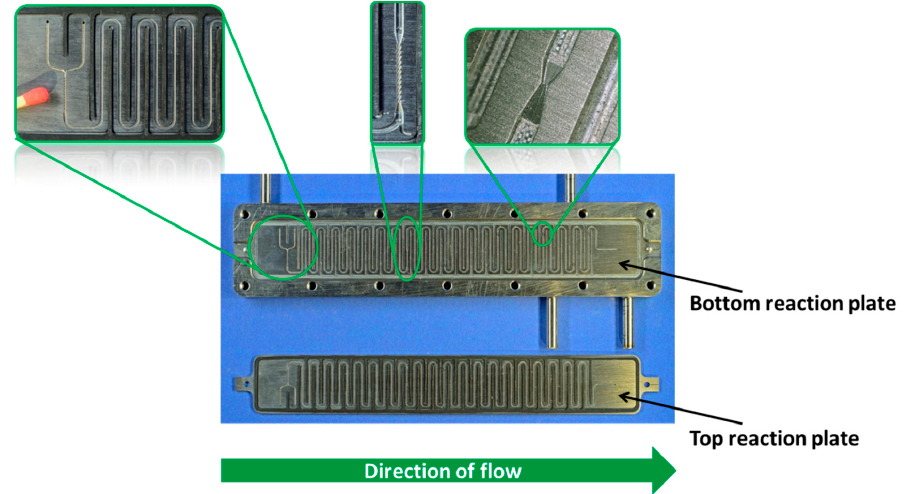
Figure 1. Orifice microreactor, top left zoom: 300 µm caterpillar micromixer for the mixing of the hydroperoxide with the potassium hydroxide, central zoom: 300 µm caterpillar micromixer for acid halide dosage, top right zoom: one of the five Venturi-like orifices.